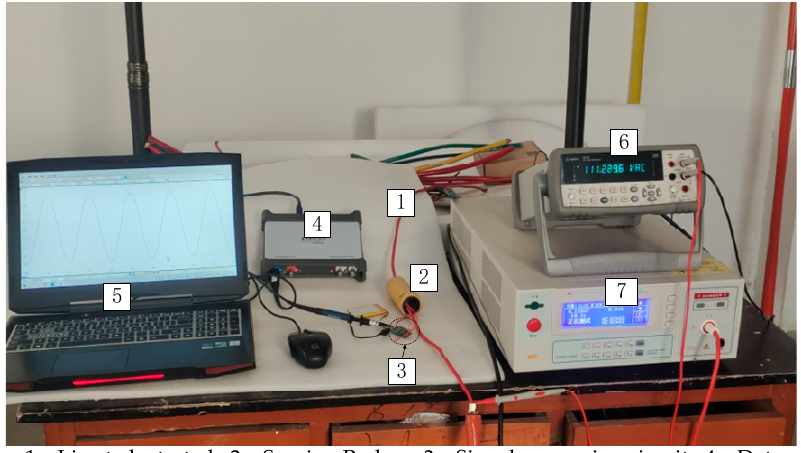
Figure 12. Sensor low voltage performance test platform.